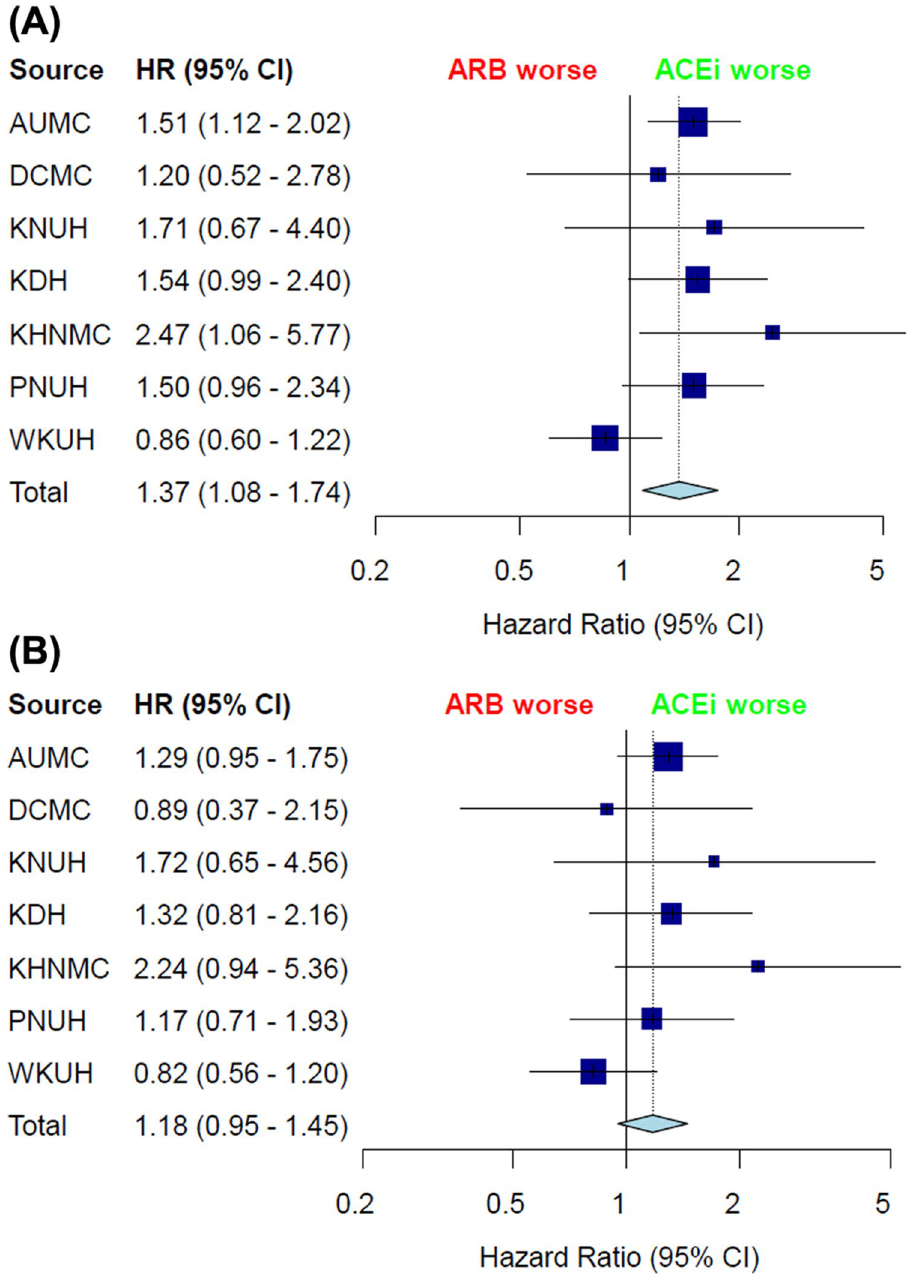
Figure 2. Incidence of lung cancer in the whole cohort ( A ) adjusted for sex and age and ( B ) PS stratified. AUMC Ajou University Medical Center, DCMC Daegu Catholic University Medical Center, KNUH Kangwon effect, seTE standard error of individual studies, HR hazard ratio, CI confidence interval, ACEi angiotensin- converting enzyme inhibitor, ARB angiotensin receptor